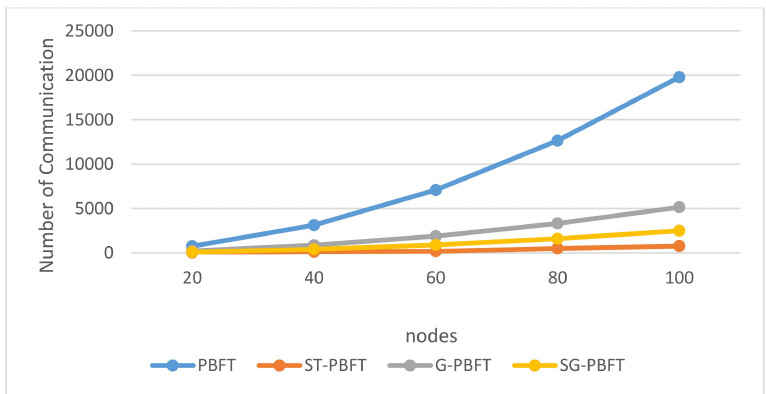
Figure 10. Comparison of communication